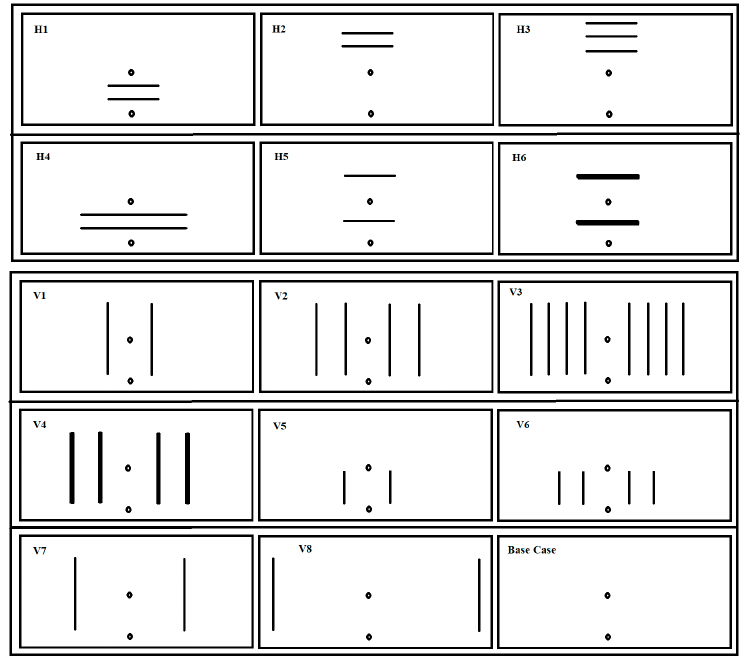
Figure 2. The fracture pattern designs.